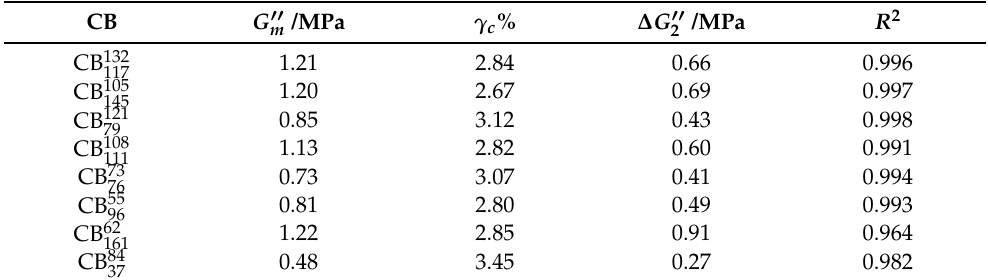
Table 7. Fitting of G (cid:48)(cid:48) ( γ ) according to Equation (9) where γ 2 has been assigned as 0.23. CB G (cid:48)(cid:48) m /MPa γ c % ∆ G (cid:48)(cid:48)